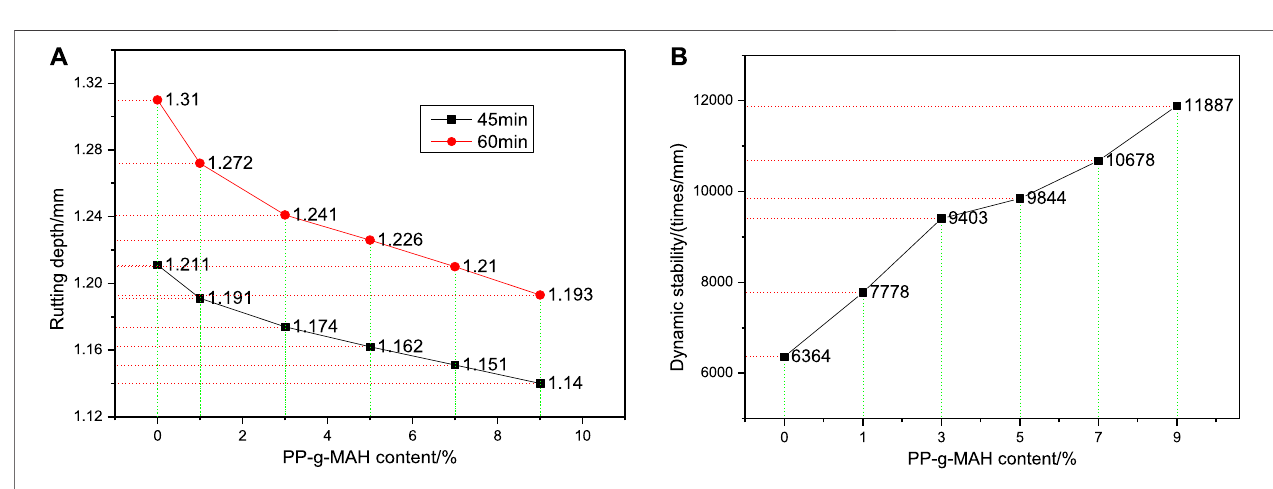
FIGURE 14 | RD (A) and DS (B) for modi fi ed asphalt with different PP-g-MAH content.